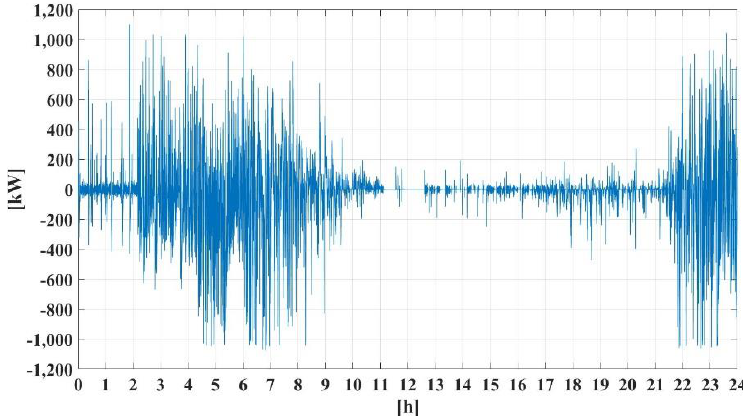
Figure 10. Field test result 1: output power of ESS.